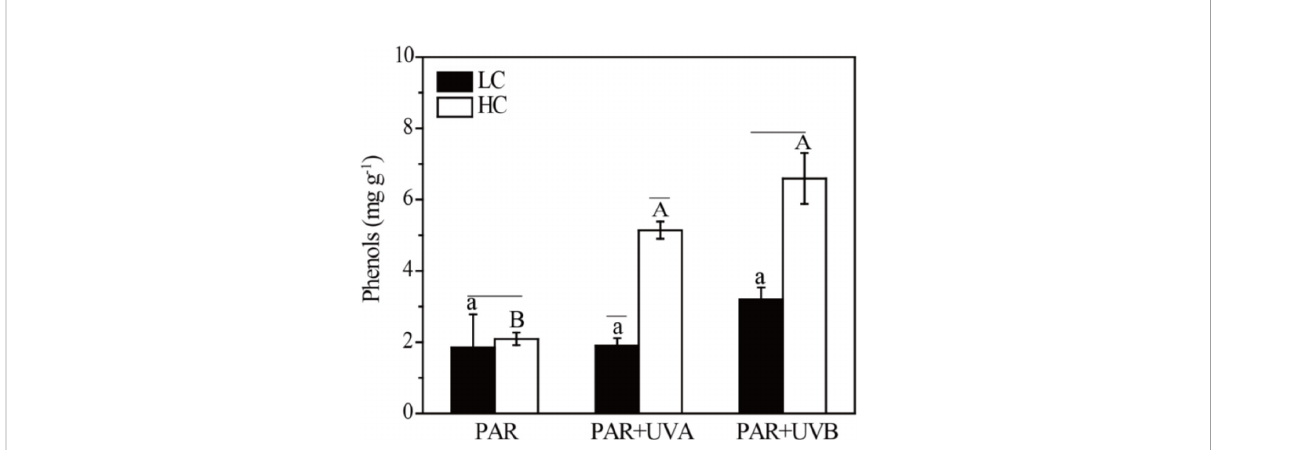
FIGURE 8 The phenols content of Rhodosorus sp. SCSIO-45730 treated under different p CO 2 levels and UVR. Short horizontal lines represent signi fi cant differences (P<0.05) among CO 2 treatments at the same UVR treatment, while long horizontal lines indicate insigni fi cant differences. Different lowercase letters represent signi fi cant differences (P<0.05) among UVR treatments under LC, and different capital letters indicate signi fi cant differences (P<0.05) among UVR treatments under